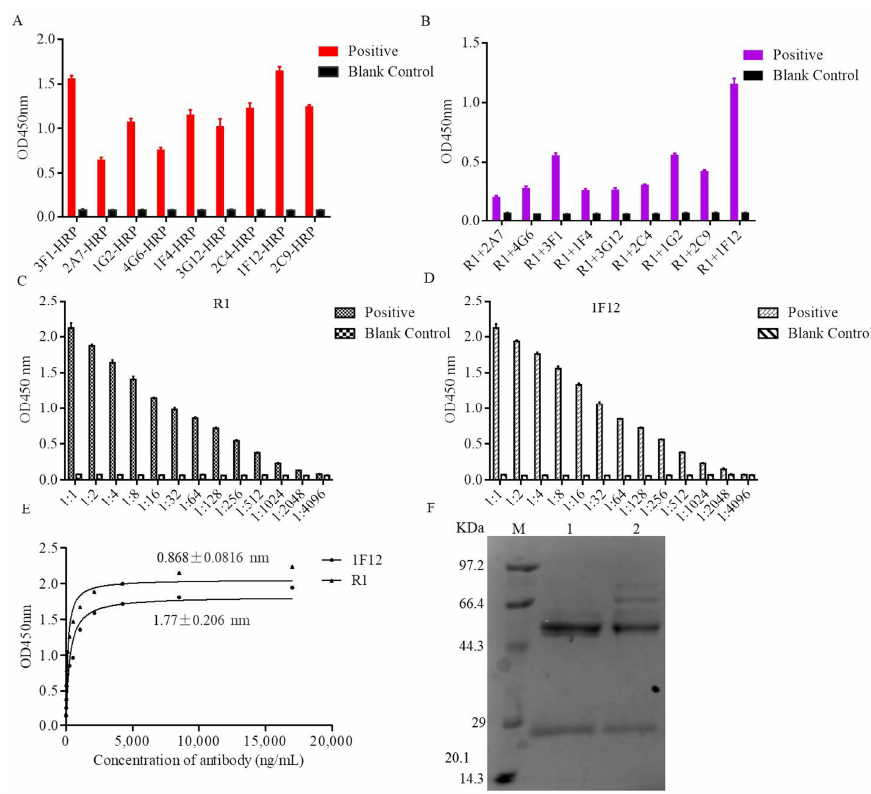
Figure 3. Characteristics of the key components of the DAS-ELISA. ( A ) The reactivity of nine mAbs conjugated with HRP, 5% skimmed milk as the blank control. ( B ) Nine different groups for DAS-ELISA, the blank control was 5% skimmed milk. The titer of pAb R1 ( C ) and mAb 1F12 ( D ) at different dilution ratios were determined by ELISA, 5% skimmed milk as the blank control. ( E ) The saturation curves for determination of the dissociation constants of mAb 1F12 and pAb R1. ( F ) SDS-PAGE analysis of purified mAb 1F12 (lane 1) and pAb R1 (lane